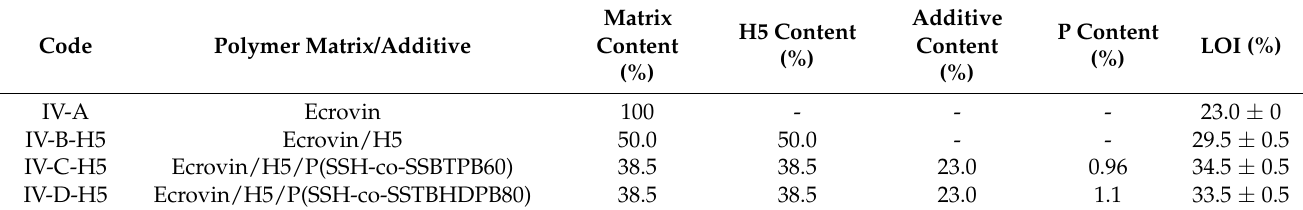
Table 8. LOI measurements of Ecrovin ® LV 340 eco blends with H5 and additives.